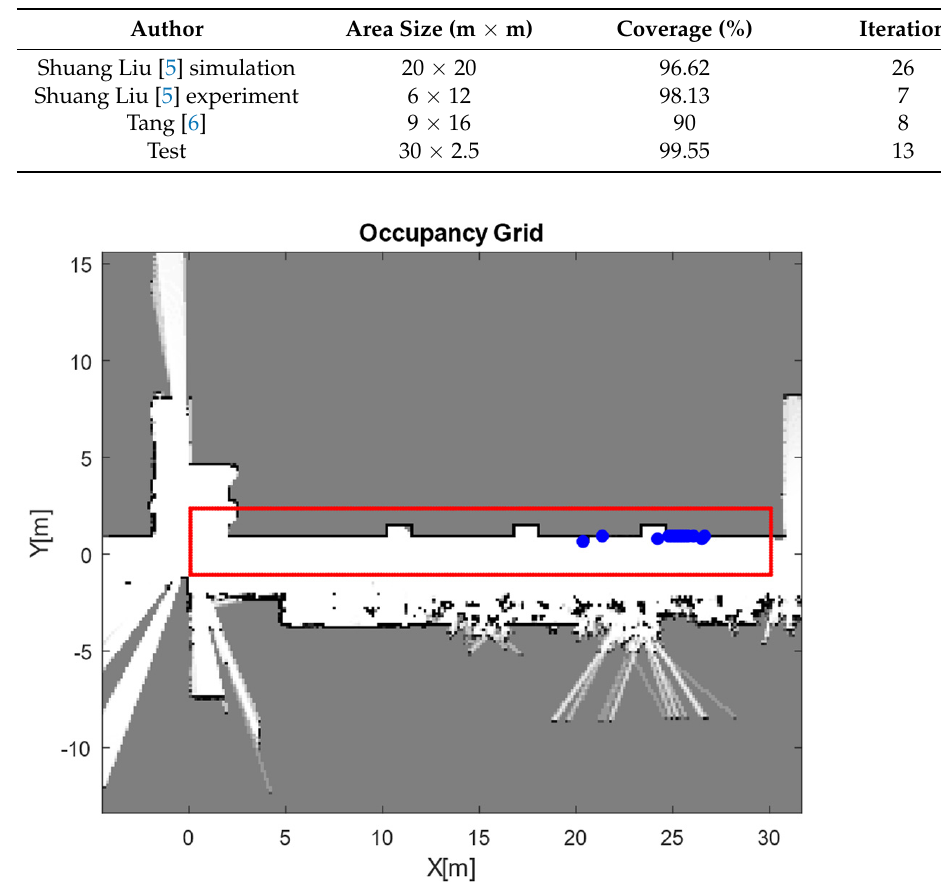
Figure 12. Generated grid map from test.